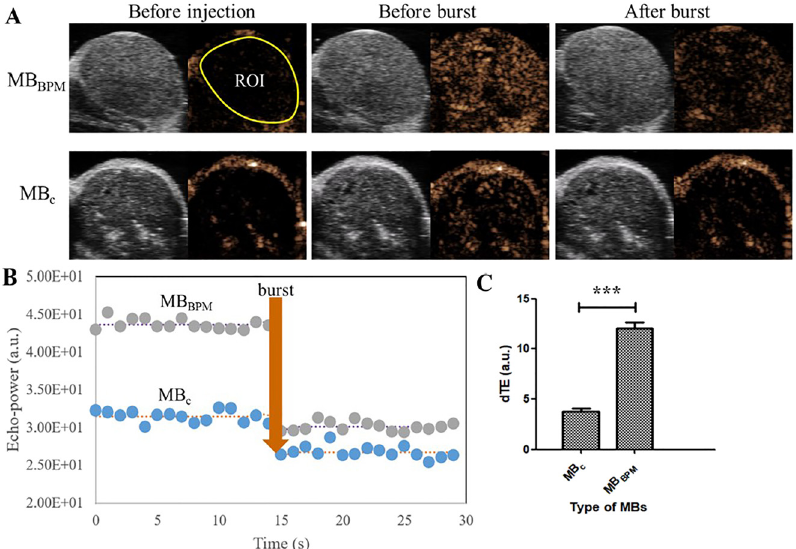
Figure 11: (A) Ultrasound images of the tumors before injection, after injection for 20 min and after the burst of MB c and MB BPM . (B) The echo – power – time pro fi le of thetumorregions(ROI)15sbeforeandafter the burst of MB c (blue dots) and MB BPM (grey dots) and their average values (MB c : orange dots and MB BPM : purple dots). (C) The differential targeted enhancement (dTE) parameter for the MB c and MB BPM . Data represent mean with SD, n = 5. * p < 0.05, ** p < 0.01, *** p <